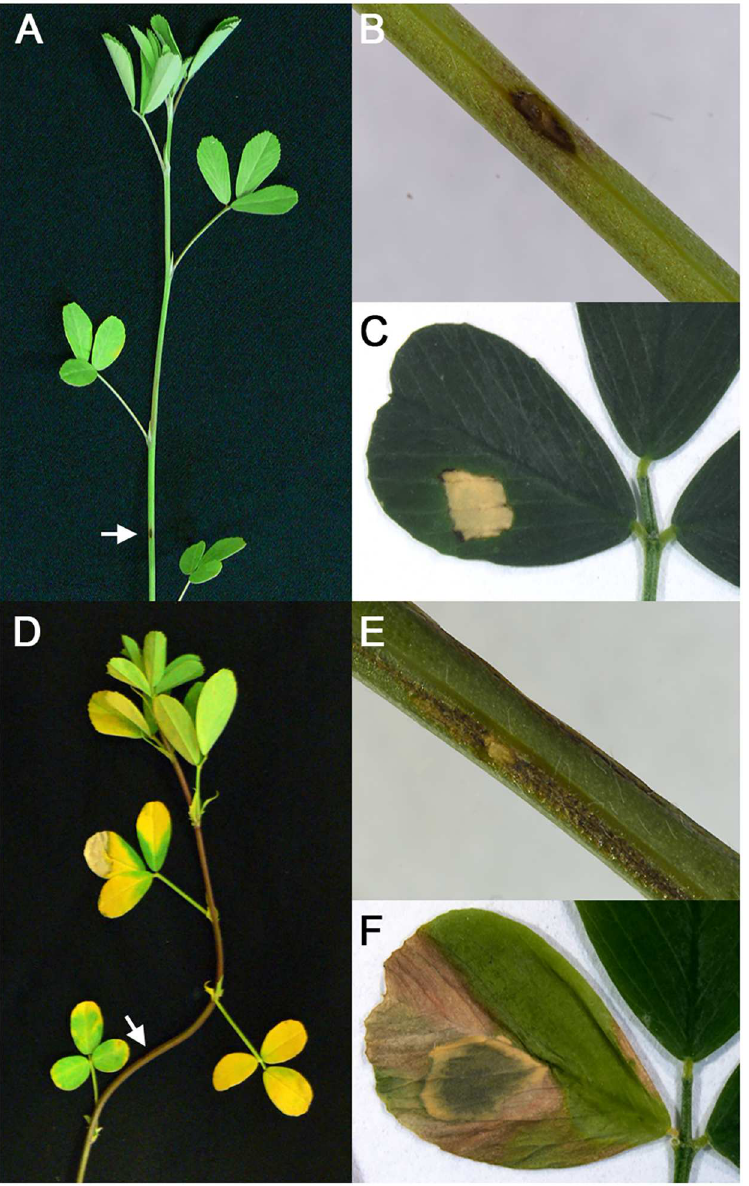
Fig 1. Symptoms of bacterial stem blight at 7 days after inoculation. (A) Responseof resistant plant. (B) Stem of resistant plant at inoculation site. (C) Leaf of resistant plant at site of infiltration. (D) Response of susceptible plant. (E) Stem of susceptibleplant at inoculationsite. (F) Leaf of susceptibleplant at site of infiltration.Arrows indicatepoint of inoculation.